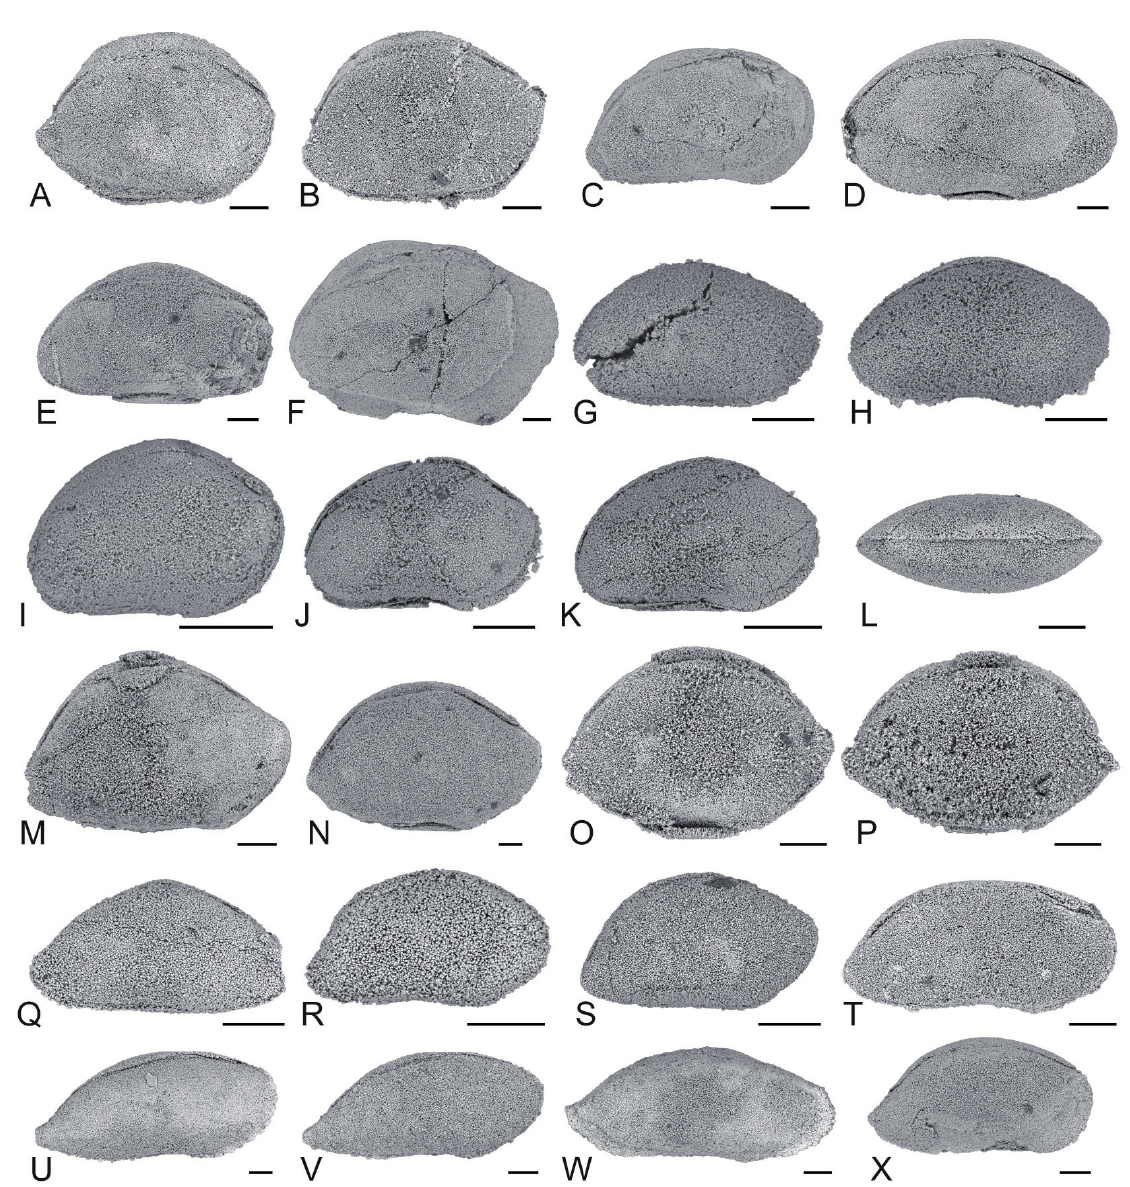
Fig. 8. Ostracods from the Dajiang section, South China. — A . Bairdia sp. 10, carapace, right lateral view, P6M2987. — B . Bairdia sp. 11, carapace, right lateral view, P6M2988. — C . Bairdia sp. 12, carapace, right lateral view, P6M2989. — D . Bairdia sp. 13, carapace, right lateral view, P6M2990. — E . Bairdia sp. 14, carapace, right lateral view, P6M2991. — F . Bairdia sp. 15, carapace, right lateral view, P6M2992. — G . Bairdia sp. 16, carapace, right lateral view, P6M2993. — H . Bairdia sp. 17, carapace, right lateral view, P6M2994. — I–L . Bairdia sp. 18. I . Carapace, right lateral view, P6M2995. J . Carapace, right lateral view, P6M2996. K . Carapace, right lateral view, P6M2997. L . Carapace, dorsal view, P6M2998. — M–N . Bairdia sp. 19. M . Carapace, right lateral view, P6M2999. N . Carapace, right lateral view, P6M3000. — O–P . Bairdia sp. 20. O . Carapace, right lateral view, P6M3001. P . Carapace, right lateral view, P6M3002. — Q . Bairdia sp. 21, carapace, right lateral view, P6M3003. — R–S . Bairdia sp. 22. R . Carapace, right lateral view, P6M3004. S . Carapace, right lateral view, P6M3005. — T . Bairdia sp. 23, carapace, right lateral view, P6M3006. — U–W . Bairdia sp. 24. U . Carapace, right lateral view, P6M3007. V . Carapace, right lateral view, P6M3008. W . Carapace, right lateral view, P6M3009. — X . Bairdia cf. sp. 24, carapace, right lateral view, P6M3010. – Scale = 100